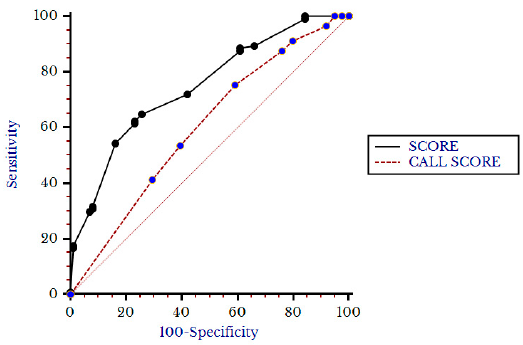
Figure 5. Comparison between Score and Call score for primary outcome.